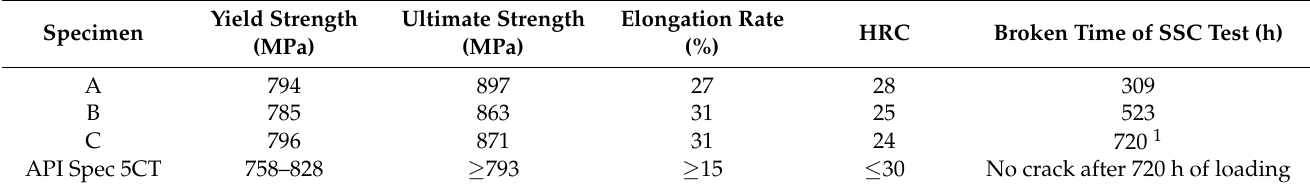
Table 2. Mechanical properties and fracture time of SSC test.